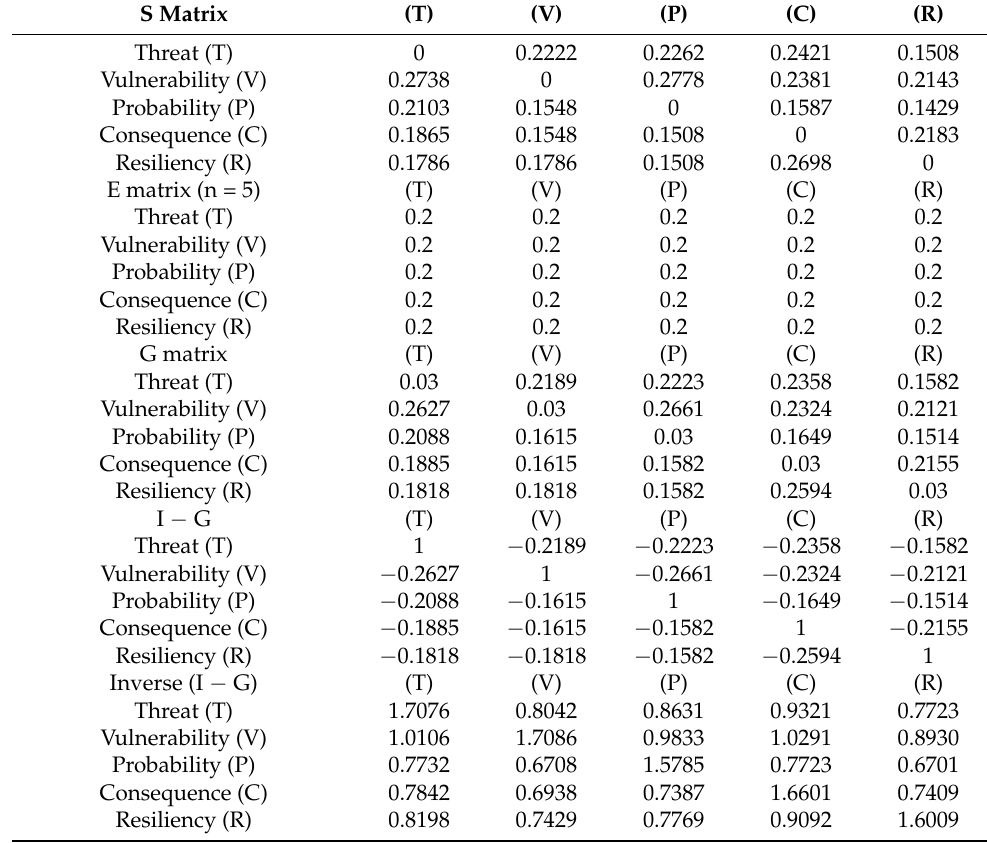
Table A2. Matrix calculations according to SNAP